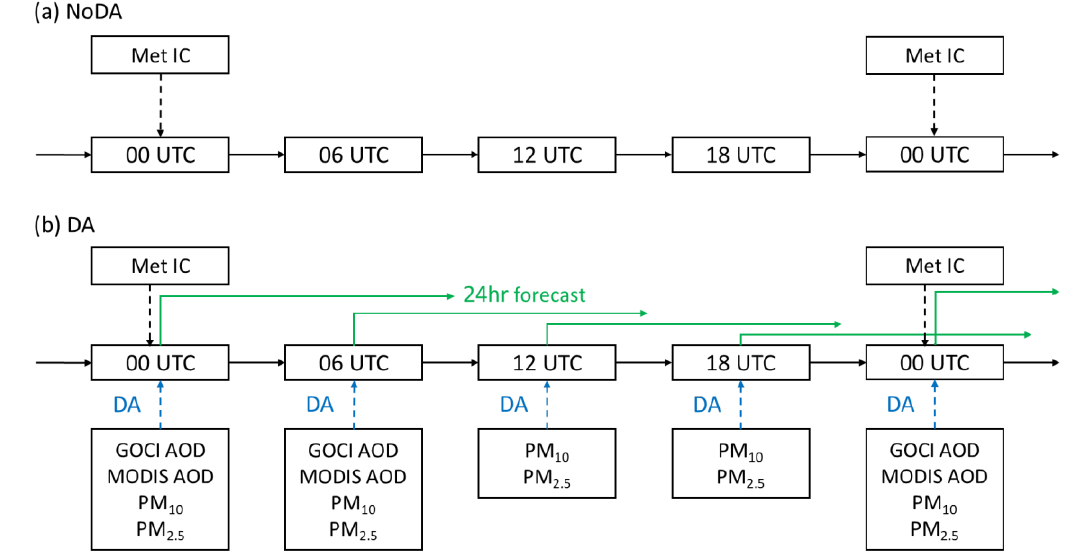
Figure 2. Schematic diagram of ( a ) NoDA and ( b ) DA experiments. The dashed line in black indicates meteorology initialization at 00 UTC every day, and the blue dashed line indicates the aerosol data assimilation with a 6 h cycle. The solid line represents the WRF-Chem model integration.